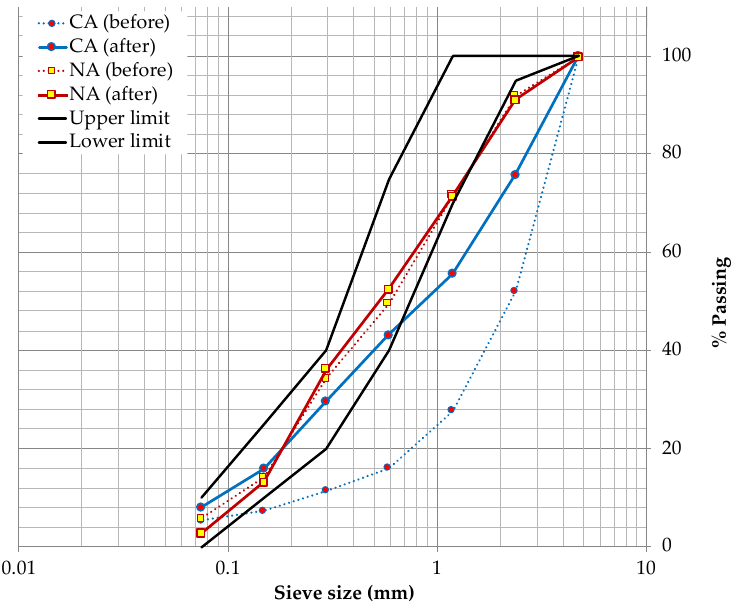
Figure 1. Recycled Ceramic Aggregate (CA) and Natural Aggregate (NA) granulometries. Table 1. Physical properties of aggregates [29].